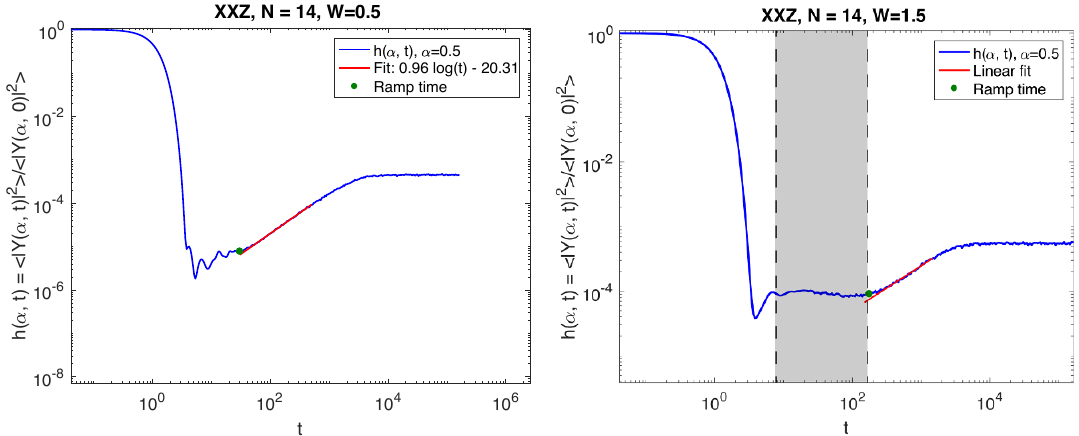
Figure 15 . [Left] h ( (cid:11) = 0 : 5 ; t ) for the XXZ Hamiltonian in the ergodic regime ( W = 0 : 5) for N = 14 qubits and total spin zero sector. [Right] The h ( (cid:11) = 0 : 5 ; t ) for the XXZ Hamiltonian in the subdi(cid:11)usive regime ( W = 1 : 5) for N = 14 qubits. The shaded region highlights an almost constant region of the spectral form factor whose origin we would like to